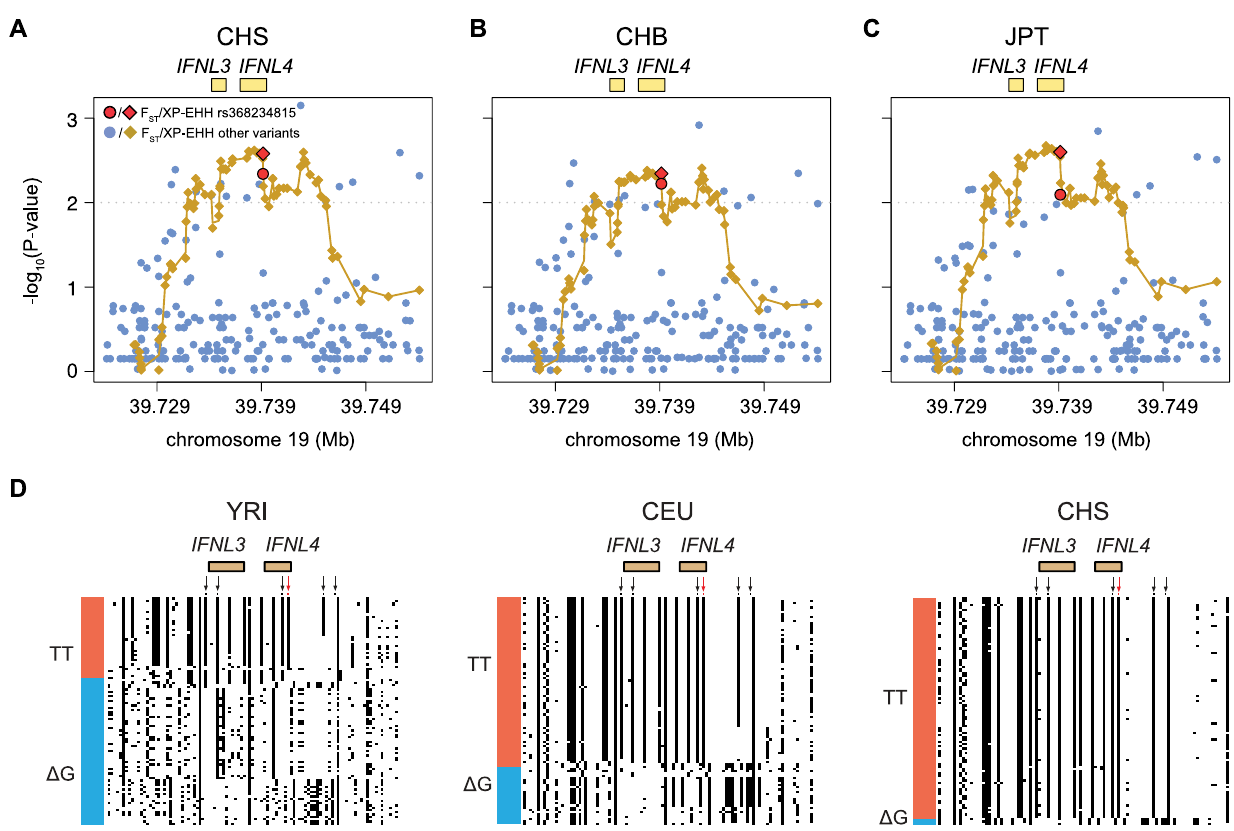
Figure 3. Empirical P-values of the F ST and XP-EHH analysis (depicted as dots or diamonds, respectively) in the 30 Kb genomic locus around IFNL4 (chr19:39724153–39754153) for (A) CHS, (B) CHB, and (C) JPT using YRI as background. All XP-EHH values are connected by a fitting curve (yellow line). The 1% tail of the genomic empirical distribution is indicated by the horizontal, dashed line. ( d ) Haplotype structure in the same region as above, for an African (YRI), European (CEU), and East Asian (CHS) population. Columns represent SNPs with a derived allele frequency . 5% in at least one population (n=99 SNPs), with the ancestral allele in white, and the derived allele in black. Lines represent the haplotypes they fall in, as inferred with SHAPEIT by the 1000 Genomes consortium [24]. Haplotypes were sorted based on rs368234815 (red arrow) and SNPs in perfect LD with it in CHS (black arrows); see also Table 2 and Figure 4. The bar on the left-hand side of each plot indicates the haplotypes that carry the TT allele (red) or the D G allele